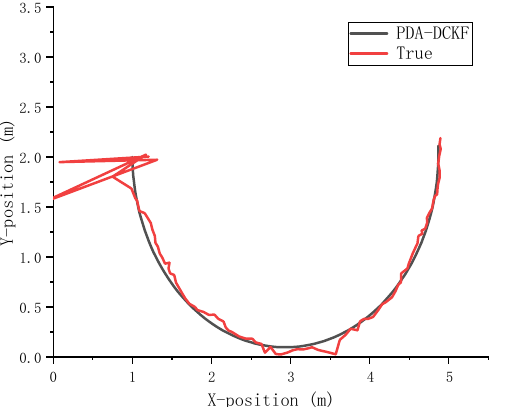
Figure 10. The tracking result of the semicircle trajectory when the SNR = 15 dB and T 60 = 400